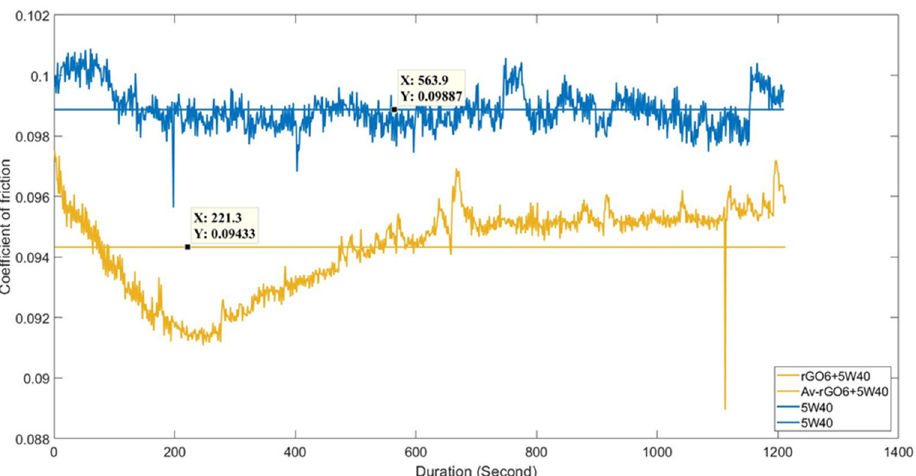
Figure 7. Friction coefficient (COF) values obtained after the first experimental reciprocating tribotest of the reference 5W-40 (blue, top) and rGO6 sample (brown, bottom), as a function of testing time.